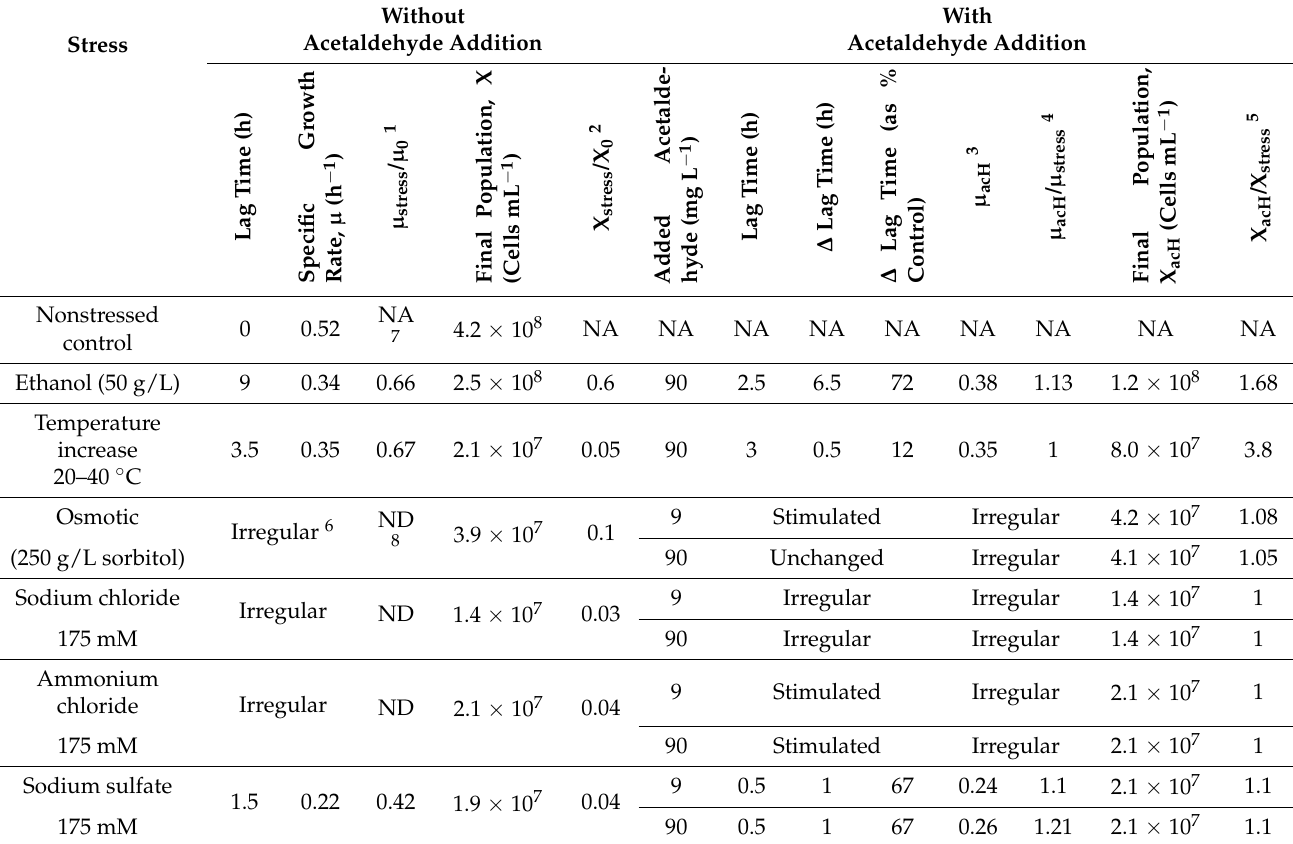
Table 2. Summary of the effects of acetaldehyde addition on the growth of Z. mobilis under various stress conditions.